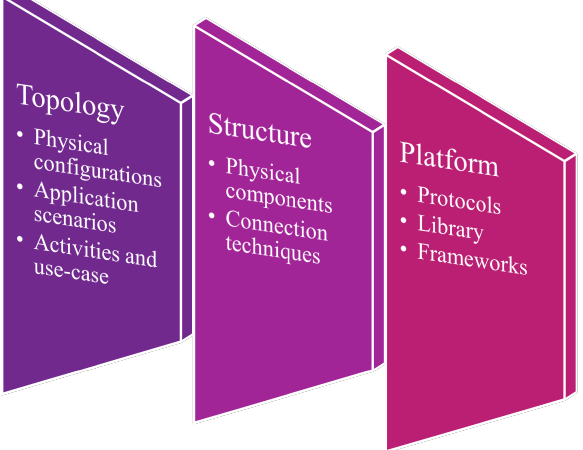
Figure 2. Three basic components and their main functions in the IoT framework for